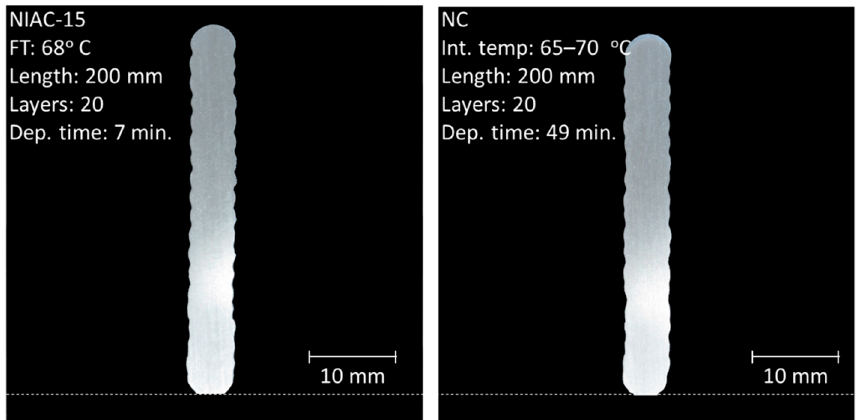
Figure 11. Comparison between 200 mm-long walls deposited with the NIAC and the NC approaches under equivalent interpass temperatures.